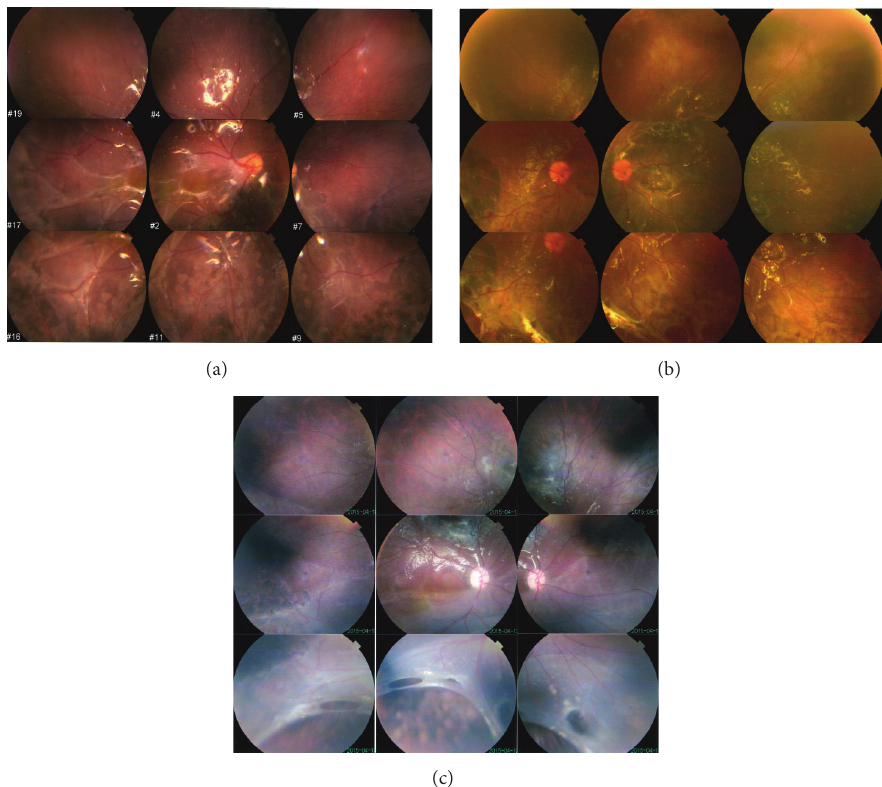
Figure 7: Fundus photographs of three children after surgery. (a) Diffuse proliferation can be observed in one child at 6 months. (b) Diffuse proliferation and peripheral retinal redetachment in 8 o’clock can be observed at 6 months. (c) The edge of the defective retina rolled inwardly to induce the peripheral retinal redetachment since 3 days after